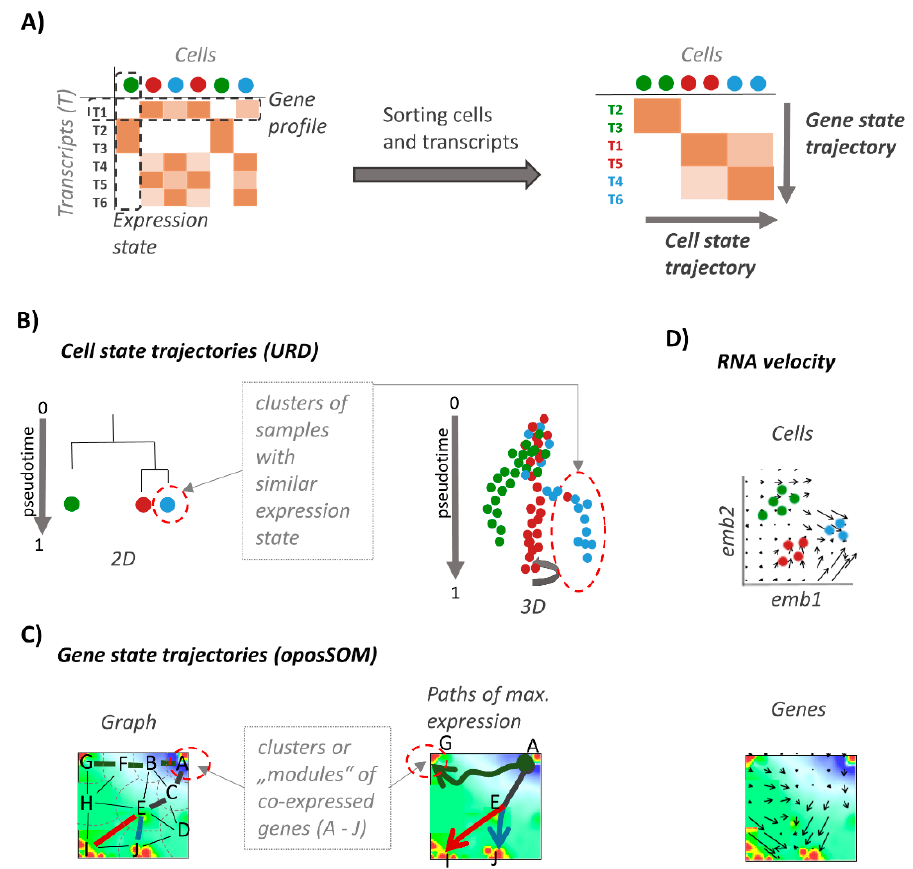
Figure 1. Analysis of developmental paths (schematic overview). ( A ) Single-cell transcriptome data are provided as a matrix of cells (columns) versus transcripts (rows). Similarity sorting along genes and cells is applied to obtain gene- and cell-state trajectories, respectively. ( B ) Multibranched cell-state trajectories order cells along a similarity measure called pseudotime (pt). They are visualized either as hierarchical tree or as three-dimensional manifold using, e.g., “URD”-plots [29]. They reflect transcriptional changes upon development and di ff erentiation of cells. ( C ) The gene-state trajectories were generated in self-organizing map (SOM)-space making use of a network formed between clusters of co-regulated genes marked with letters in the figure. Trajectories follow paths of maximum expression linking source (stem cells) and sink (di ff erentiated tissues) nodes along the edges of the net. ( D ) RNA velocity analysis delivers vector fields in cell and gene phase space. Each vector points in direction of increasing transcript abundance either between cell states or between gene states. In fact, RNA velocity forecasts the “future” transcriptional state of each gene. The RNA-velocity vector of the cells is formed by the RNA-velocities of all genes as components while the RNA-velocity vector in gene space is composed by the RNA-velocities of all genes in the respective local gene cluster.